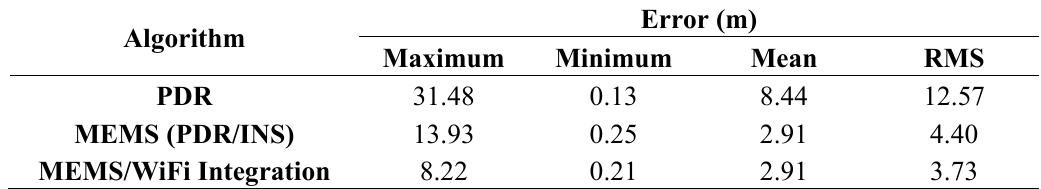
Figure 10. Navigation results of PDR, the proposed MEMS solution, and WiFi/MEMS integration (Trajectory I: Pedestrian 1, Smartphone A). ( a ) Trajectories; ( b ) Cumulative error percentages. Table 1. Positioning performance of different algorithms in Trajectory